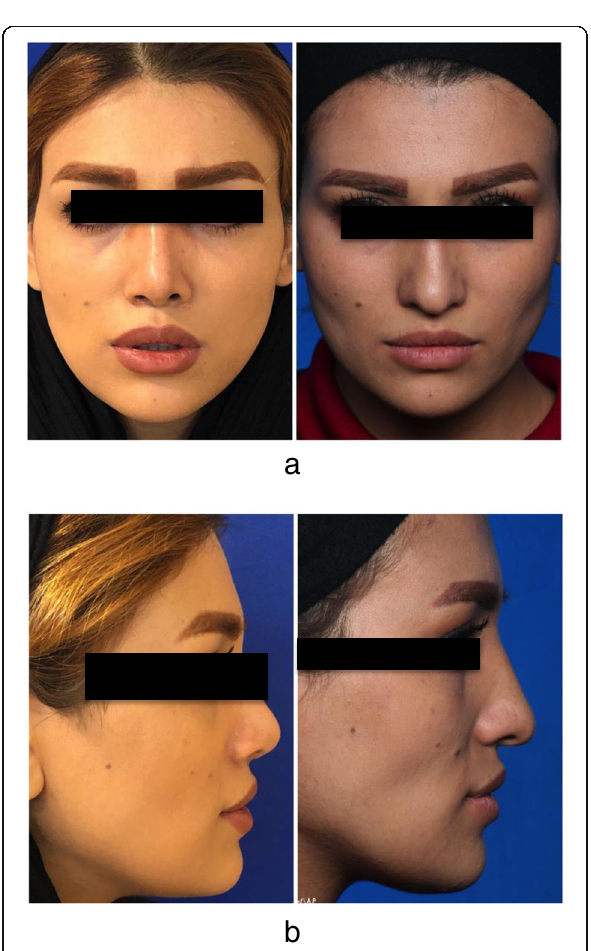
Fig. 2 Clinical presentation before and after surgery. a Frontal view before and after surgery. b Lateral view before and after